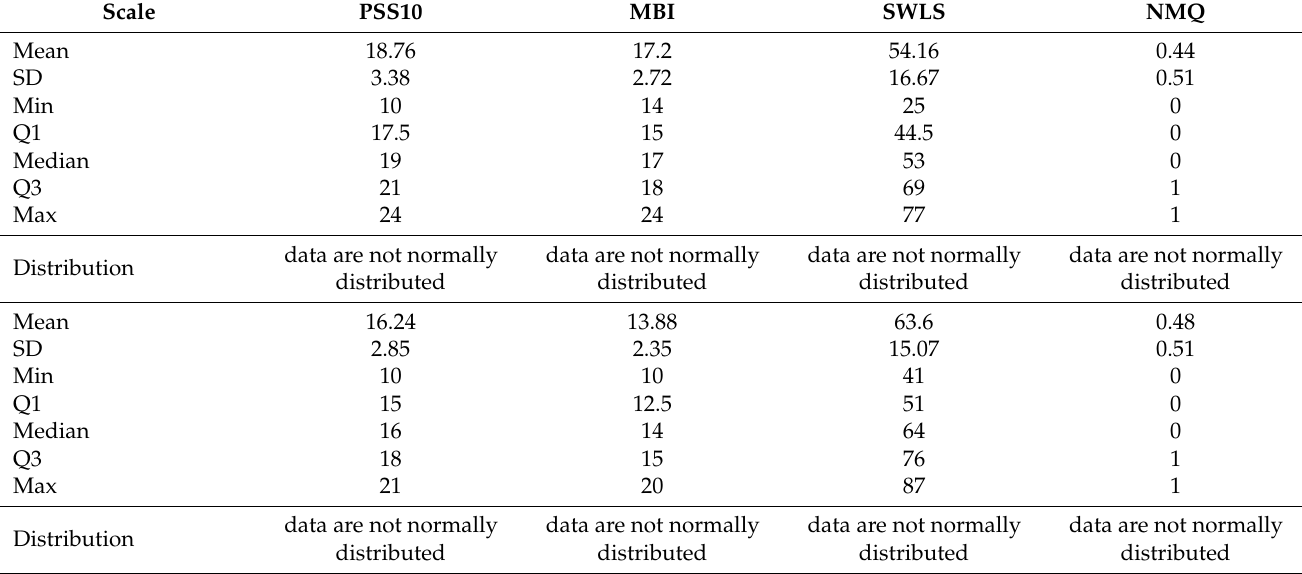
Table 5. Results for the reference group.